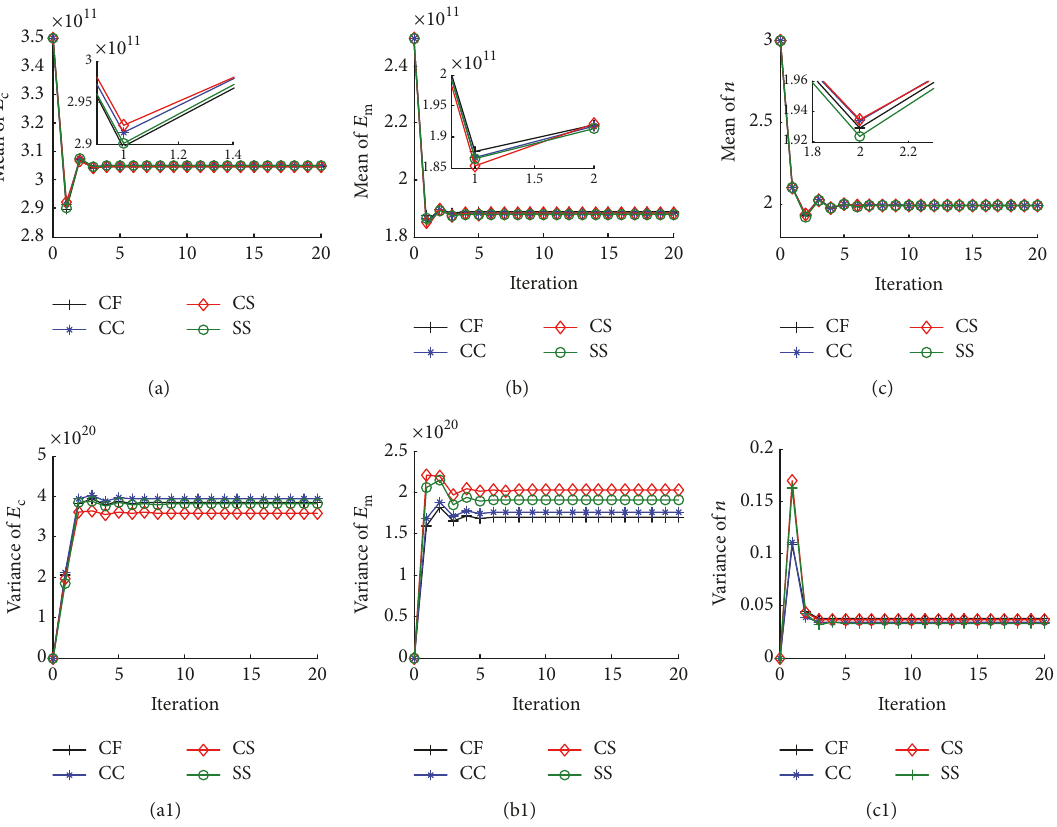
Figure 6: Iterative process of means and variances of 𝐸 c , 𝐸 m , and 𝑛 for different boundary conditions ( 𝑇 = 600 k).